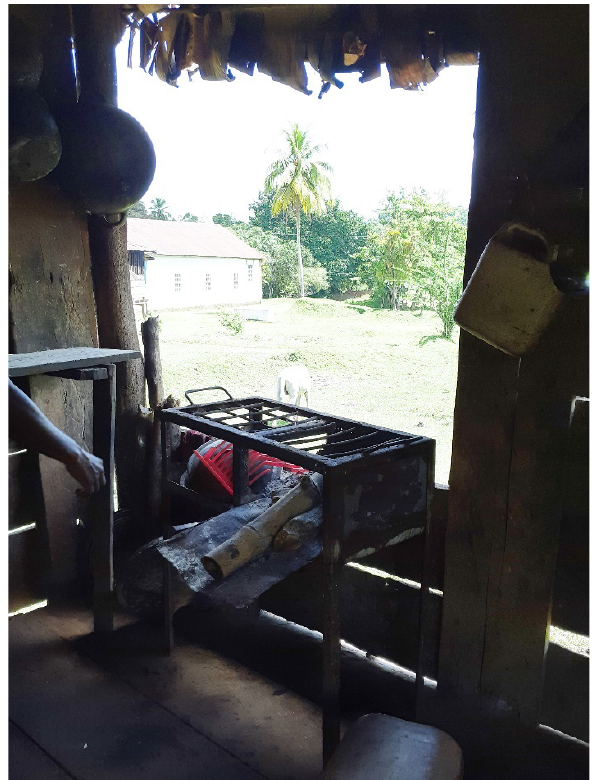
Figure 3. Inner view of a Mayangna dwelling in Santa María, Bonanza (Nathalia